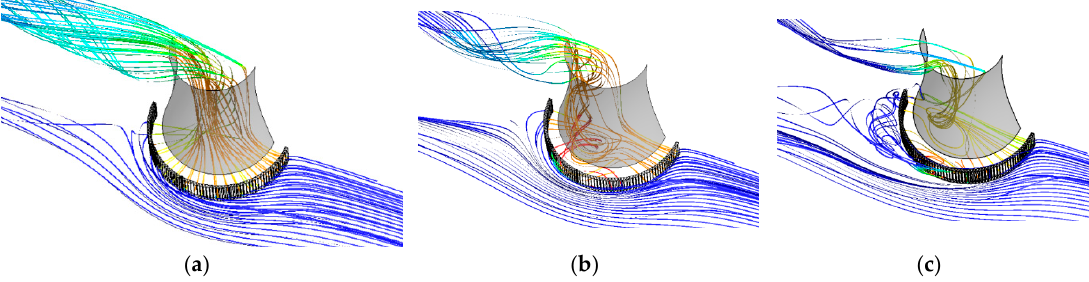
Figure 8. Streamlines colored by temperature for case A at various wind speeds. ( a ) at 4 m/s; ( b ) at 12 m/s; ( c ) at 20 m/s.